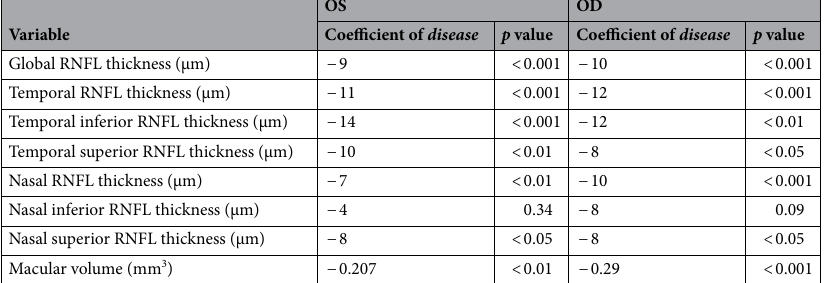
Table 3. Results of linear regression modelling with baseline OCT data. The coefficient of disease and its associated p value is shown for each retinal region as well as for macular volume. OS, Left eye; OD, Right eye.